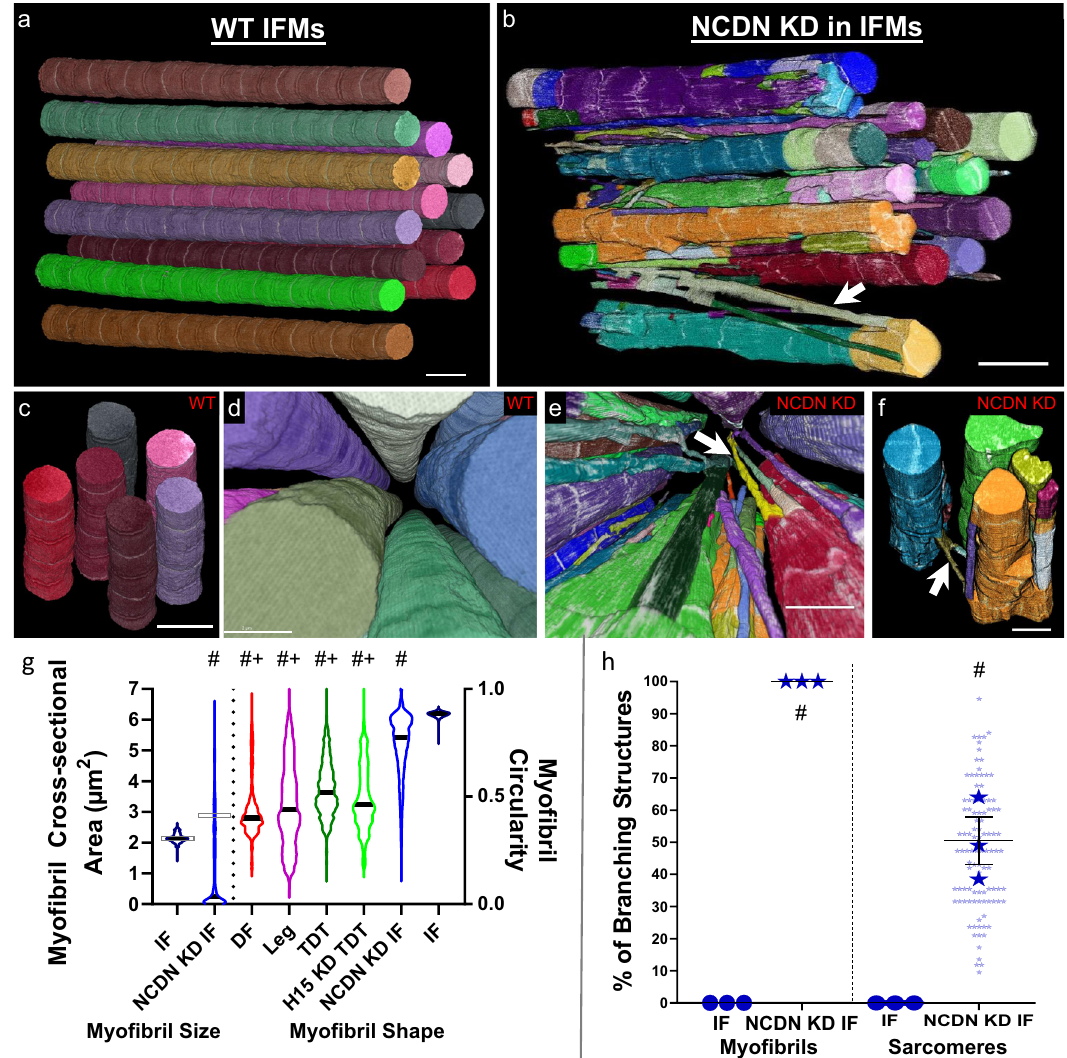
Fig. 4 Loss of NCDN turns on myo fi brillar connectivity in fi brillar indirect fl ight muscles. a – f 3D renderings of NCDN knockdown ( b , e , f ) and wild-type ( a , c , d ) IF muscles showing myo fi brillar networks at different angles. g Assessment of myo fi bril size per myo fi bril for IF and NCDN KD IF muscles (left) and myo fi bril shape for tubular muscles, IF, and NCDN KD IF muscles (right). Hash sign (#): Signi fi cantly different from fi brillar IF. Plus sign ( + ): Signi fi cantly different from NCDN KD IF (one-way ANOVA, P < 0.05). Gray boxes indicate volume-weighted average. h Percentage of myo fi brils with at least one branching sarcomere (left) and percentage of sarcomeres that branch (right) in wild type IF and NCDN KD IF muscles. N values: IF — 3 muscle cells, 3 datasets, 114 myo fi brils, 982 sarcomeres and NCDN KD IF — 3 muscle cells, 2 datasets, 100 myo fi brils, 878 sarcomeres. Larger shape symbols represent data from a single cell and smaller shape symbols represent data from a single myo fi bril. Bars represent muscle cell overall mean ± SE. Hash sign (#): Signi fi cantly different from fi brillar IF (two-sided, independent t test, P < 0.01). Scale bars — 2 μ